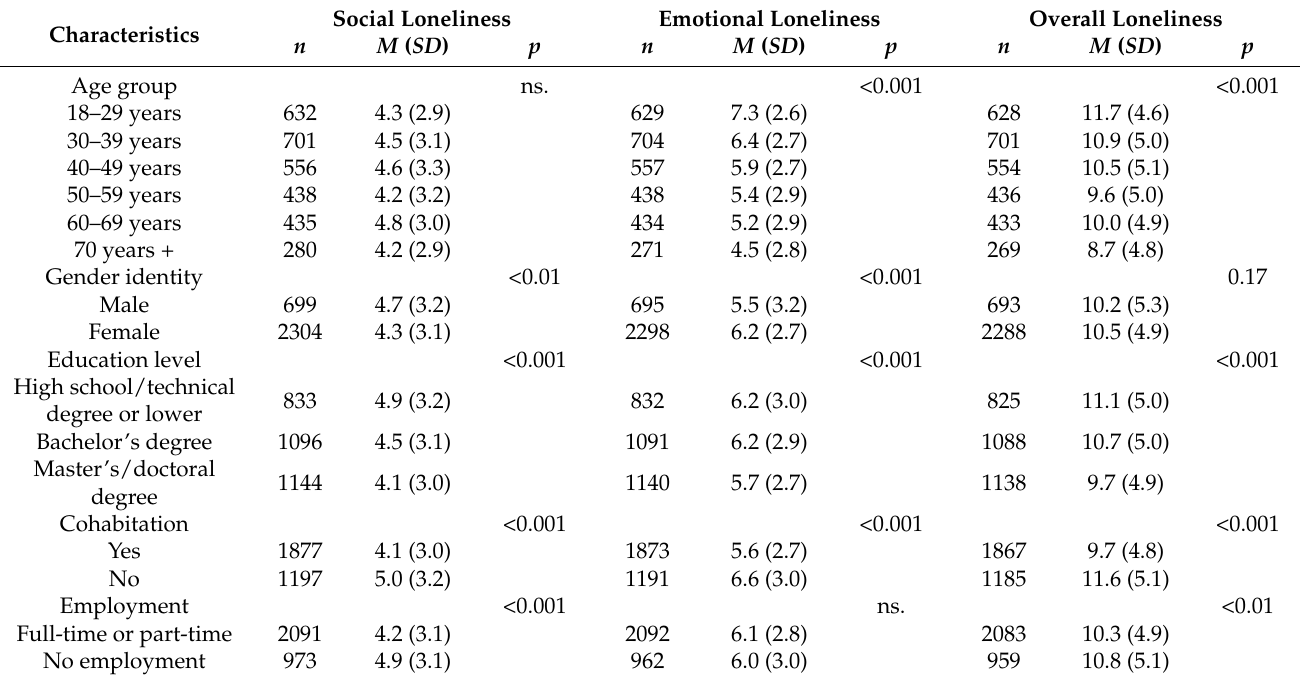
Table 1. Social, emotional, and overall loneliness in sample